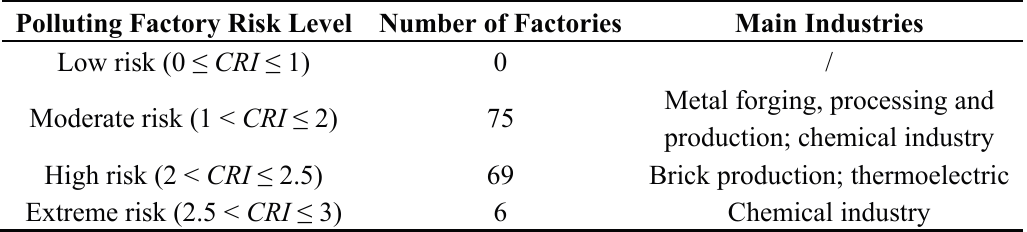
Table 4. Overview of polluting factory risk in the study